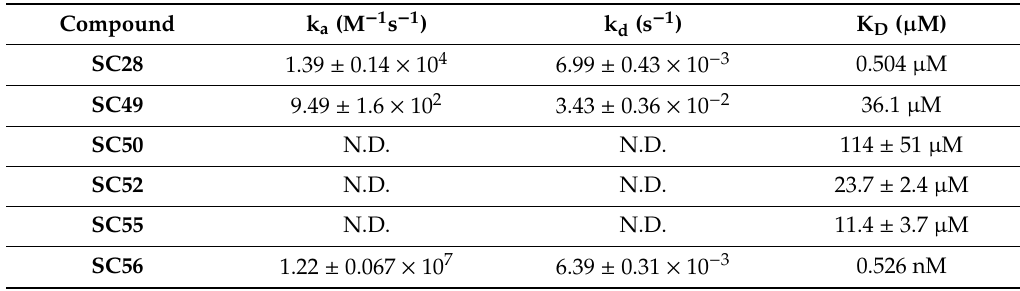
Table 3. Kinetics and a ffi nity of novel SC28 derivatives binding to soluble, cleaved recombinant Env. N.D. = not determined.